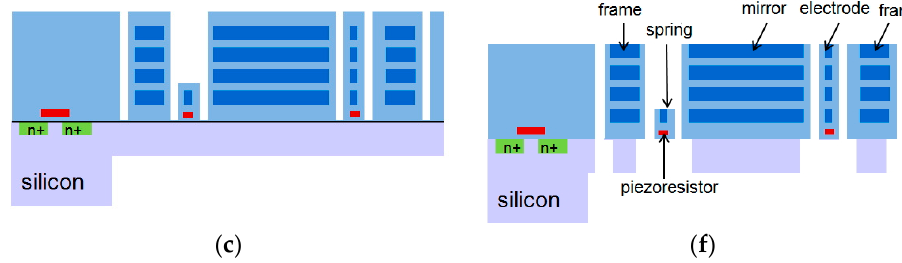
Figure 3. Post CMOS fabrication of the bi-axial scanning micro-mirror: ( a ) after CMOS process; ( b ) backside deep reactive ion etch of silicon to define the structural thickness; ( c , d ) wet etch of stacked metal and via layers followed by front-side deep reactive ion etch of silicon to form the structure; ( e ) XeF 2 silicon etch; ( f ) dielectric reactive ion etch of the top passivation to expose the top metal of micro-mirror and bond pads.